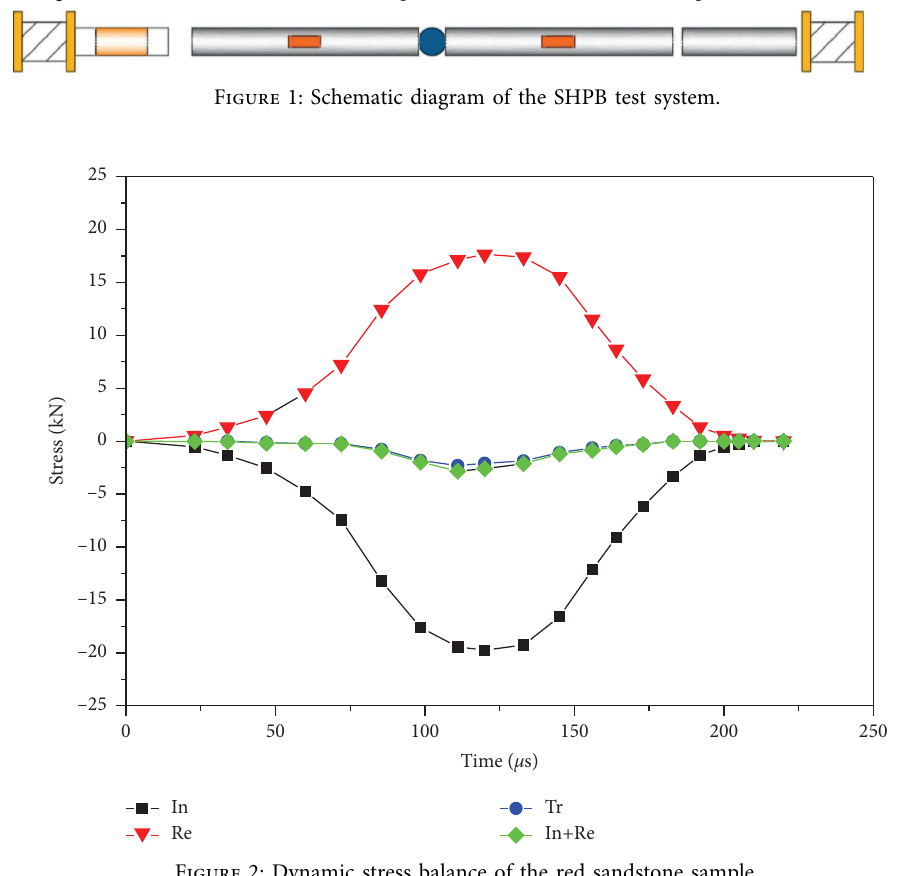
Figure 2: Dynamic stress balance of the red sandstone